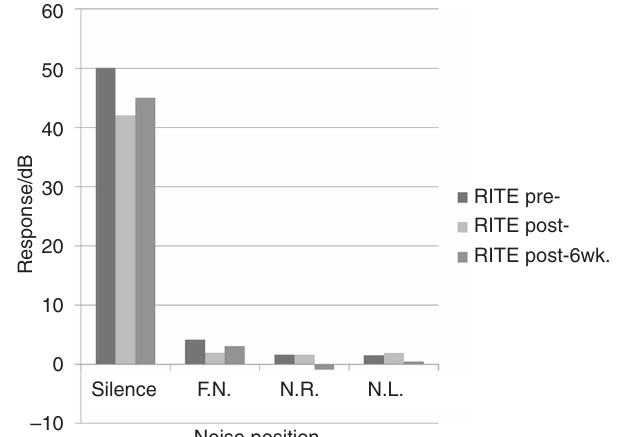
Responses in group 2 obtained with the application of the hearing in noise test (HINT) at three times: without hear- ing aid (HA), with HA, and six weeks after the fitting ( n =